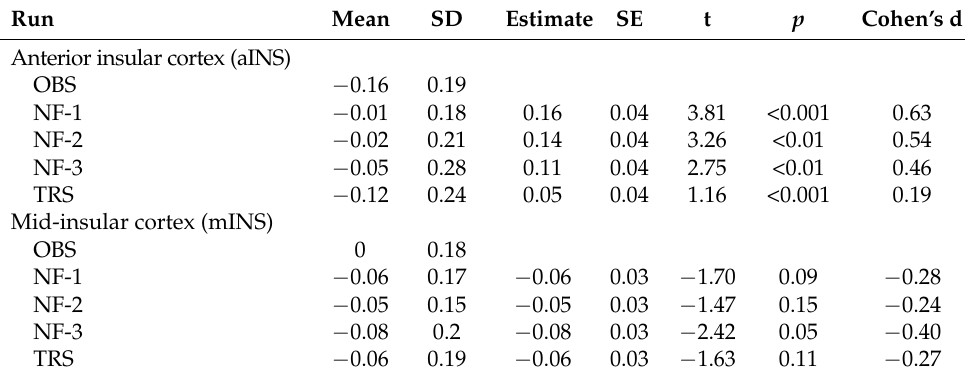
Table 4. Unadjusted means, standard deviations, effect sizes, and main analyses of fMRI coefficient for the Focus-on-Breath vs. Describe contrast in subregions of insula across runs.